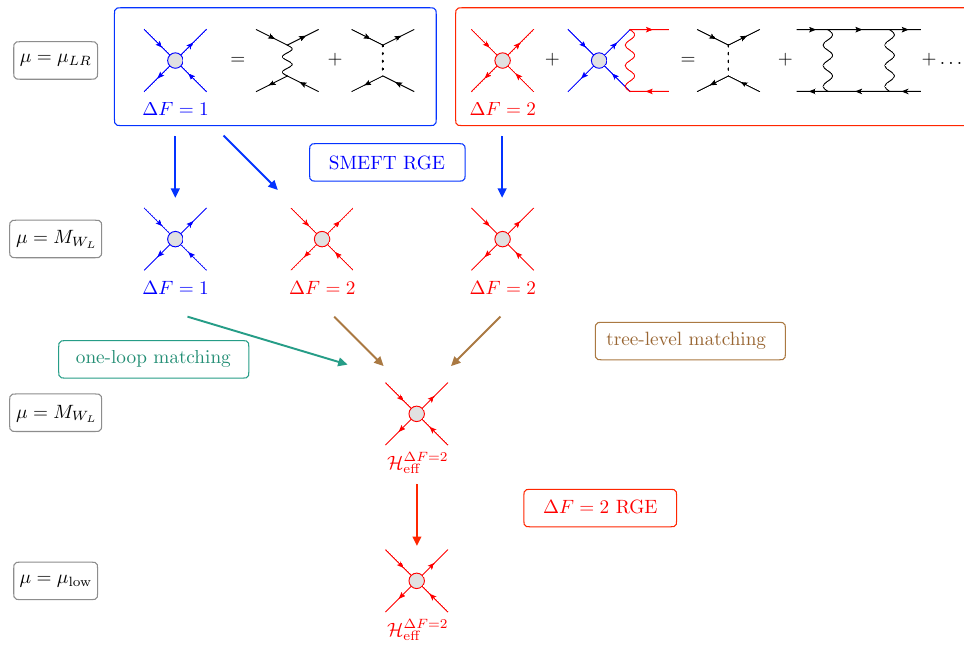
Figure 2 . Schematic (cid:12)gure for the SMEFT framework in the left-right symmetric